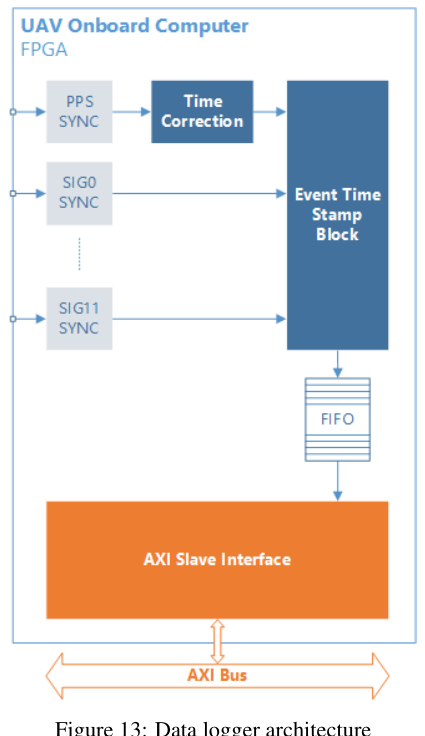
Figure 13: Data logger architecture